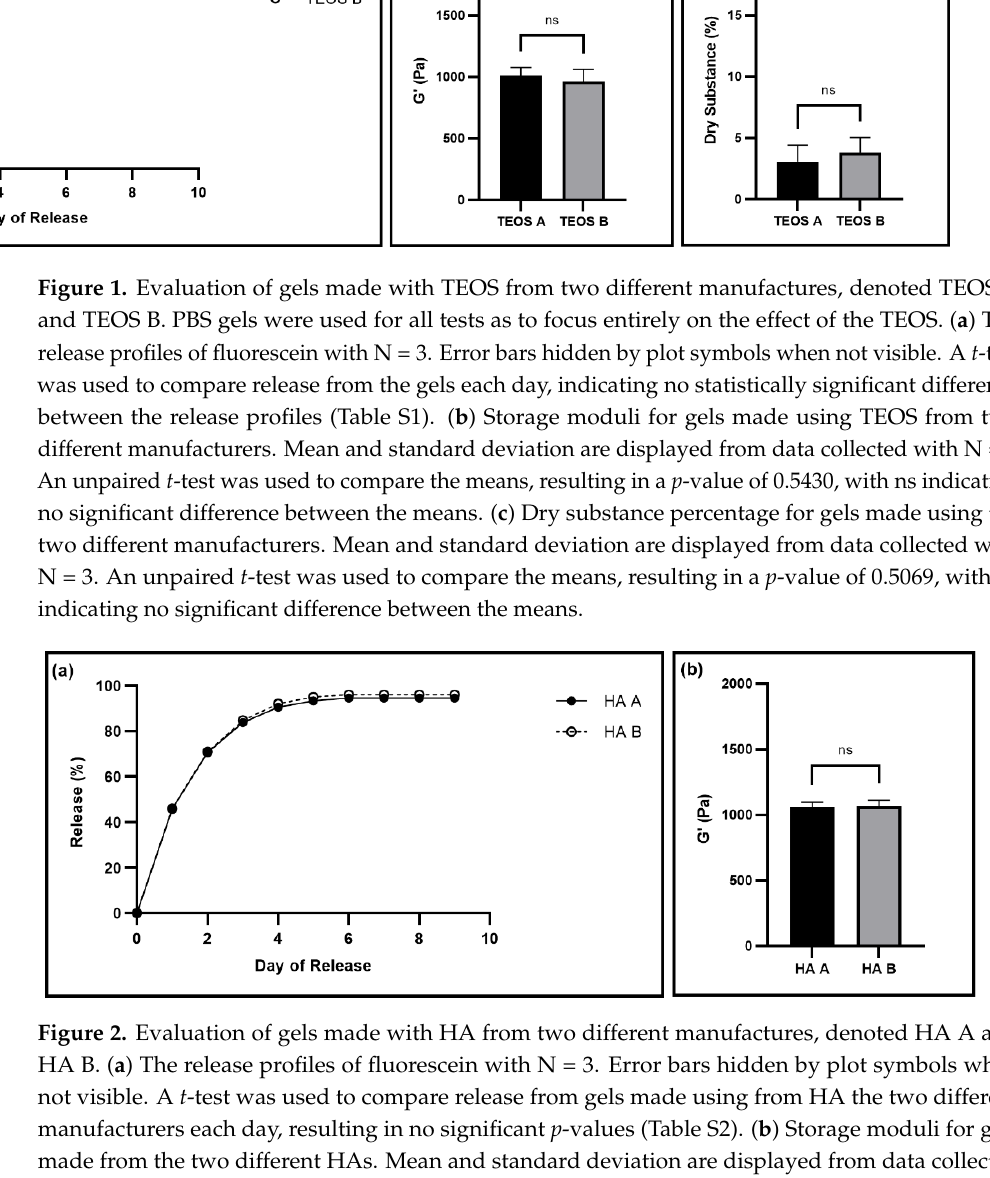
Figure 2. Evaluation of gels made with HA from two different manufactures, denoted HA A and HA B. ( a ) The release profiles of fluorescein with N = 3. Error bars hidden by plot symbols when not visible. A t -test was used to compare release from gels made using from HA the two different manufacturers each day, resulting in no significant p -values (Table S2). ( b ) Storage moduli for gels made from the two different HAs. Mean and standard deviation are displayed from data collected with N = 3. An unpaired t -test was used to compare the means, resulting in a p -value of 0.5656, with ns indicating no significant difference between the means.